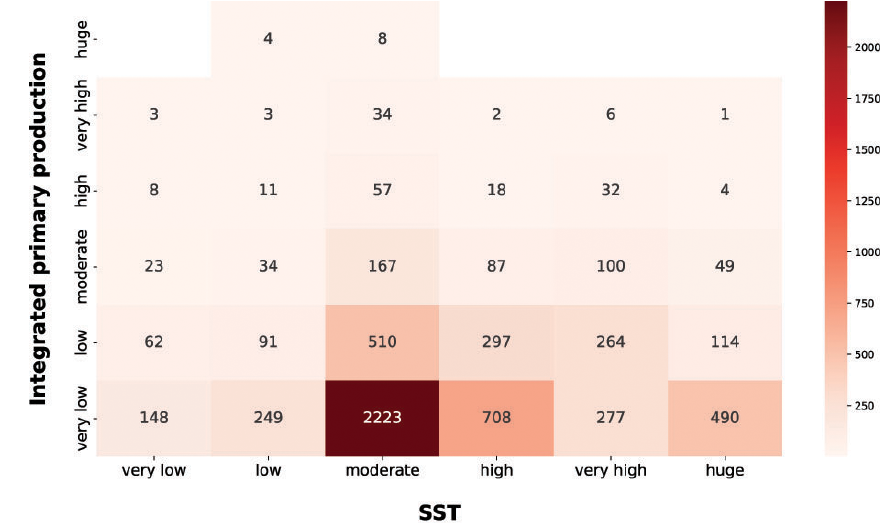
Figure 13. IPP vs. SST. The red heatmap represents the relationship between depth-integrated production and SST.